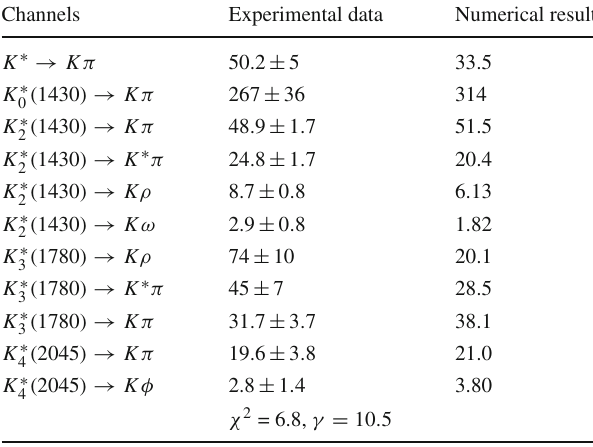
Table 4 The parameter γ fitting in the QPC model. The unit of the width is MeV Channels Experimental data Numerical result